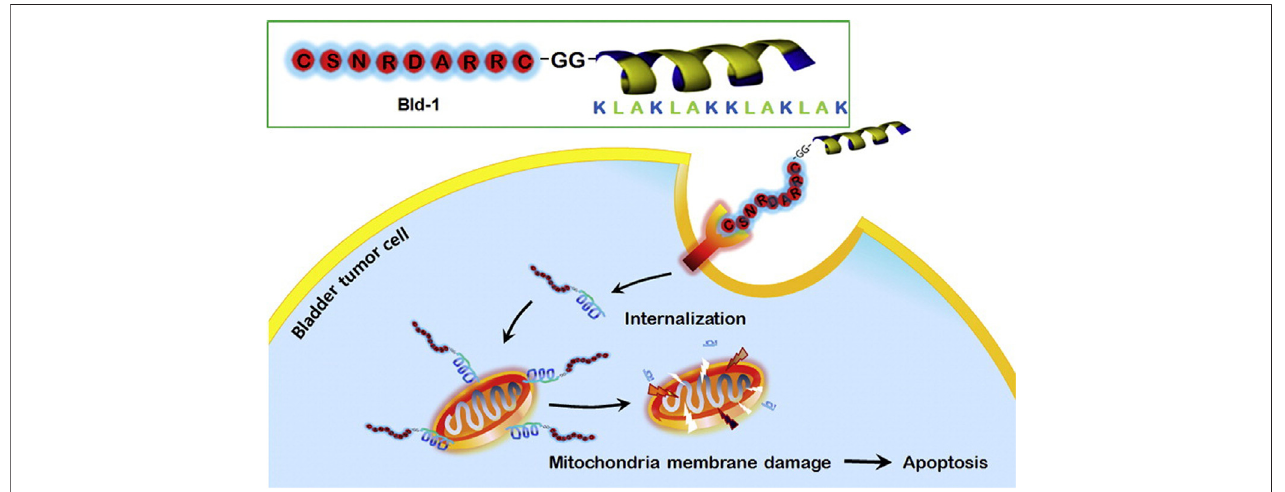
FIGURE 4 | Bld-1-KLA destroys the mitochondrial membrane and induces